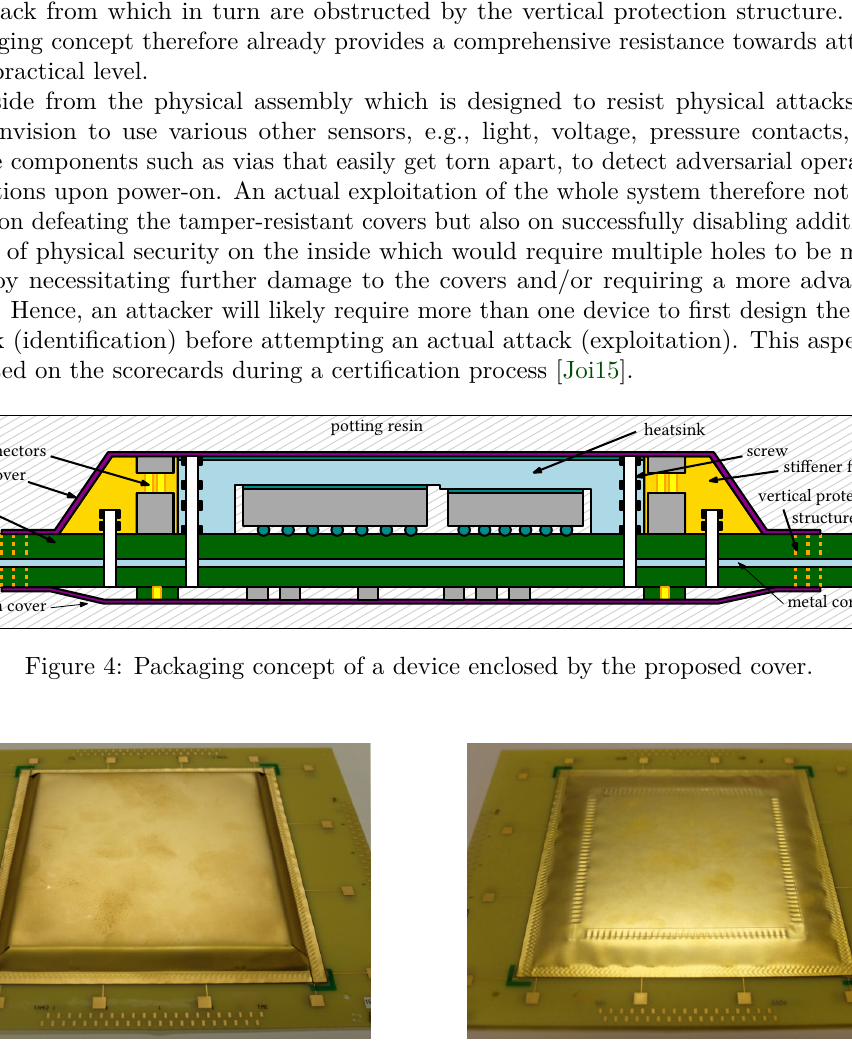
(a) Top cover. (b) Bottom cover. Figure 5: Assembly dummy at an early stage of the packaging